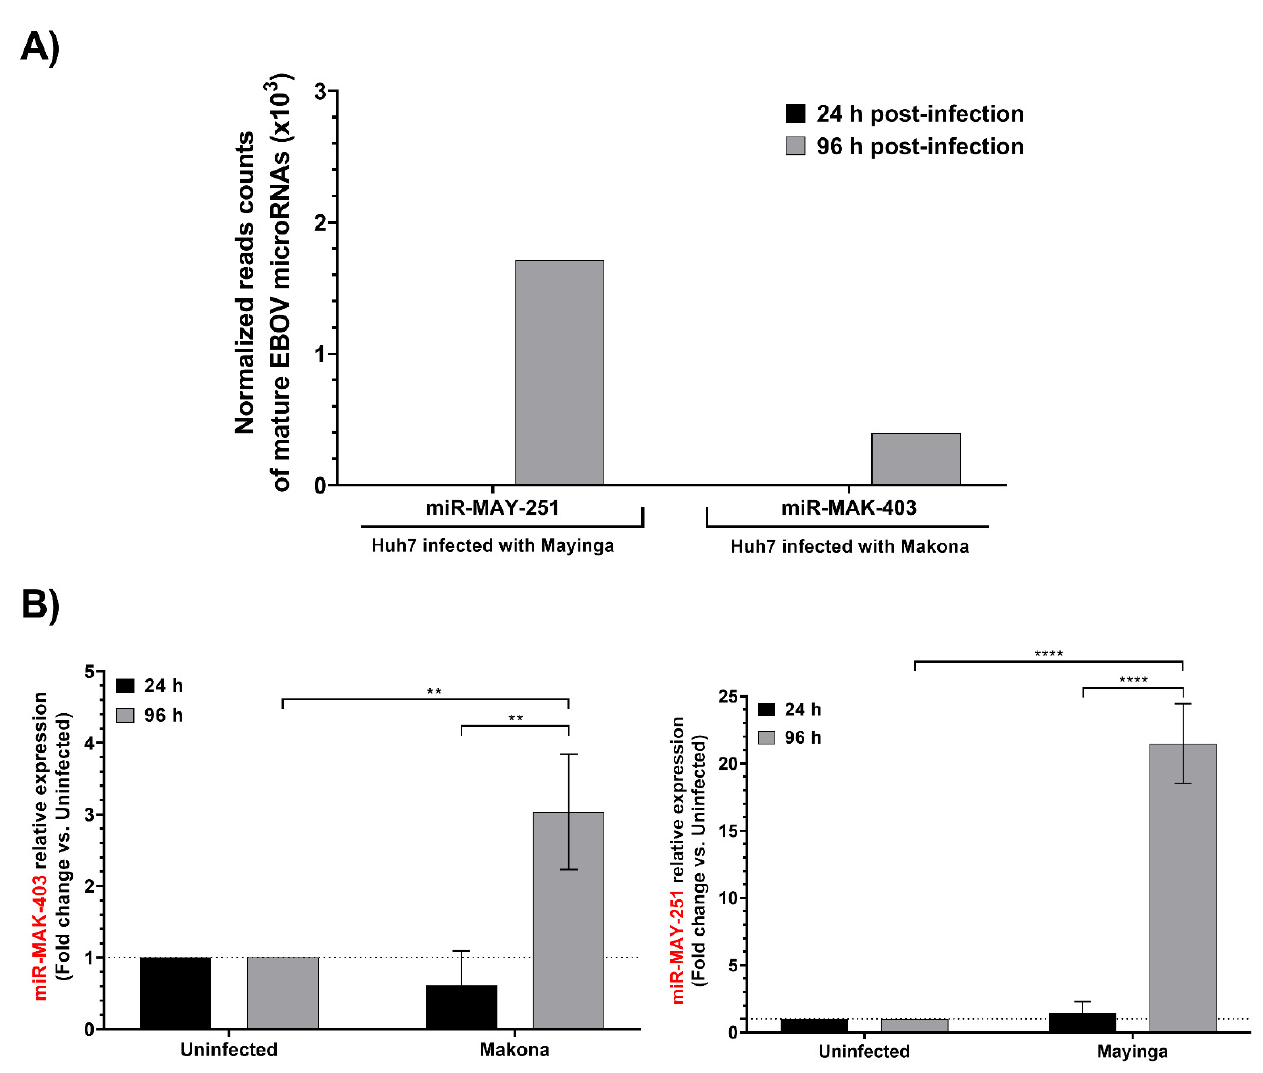
Figure 3. Expression of EBOV miR-MAY-251 and miR-MAK-403 in EBOV-infected Huh7 cells. ( A ) MicroRNA expression profiling data for the two putative EBOV microRNA sequences at 24 h and 96 h post-infection (see Section 4 and reference [33]). ( B ) RT-qPCR confirmation of the RNA-seq data showing relative expression of EBOV miR-MAY-251 and EBOV miR-MAK-403 in Huh7 cells infected for 24 h and 96 h with EBOV Mayinga or Makona variants, respectively. qPCR data were normalized with UniSp6 spike-in, reported to control (uninfected), and expressed with a relative quantitation method (ddCT). qPCR data were calculated from three biological replicates and expressed as means ± SD. Statistical analysis: The two-way analysis of variance (ANOVA) and the Sidak multiple comparisons test were used for statistical analysis. Statistically significant differences (fold change vs. uninfected) are indicated as follows: ** p < 0.01; **** p < 0.0001.